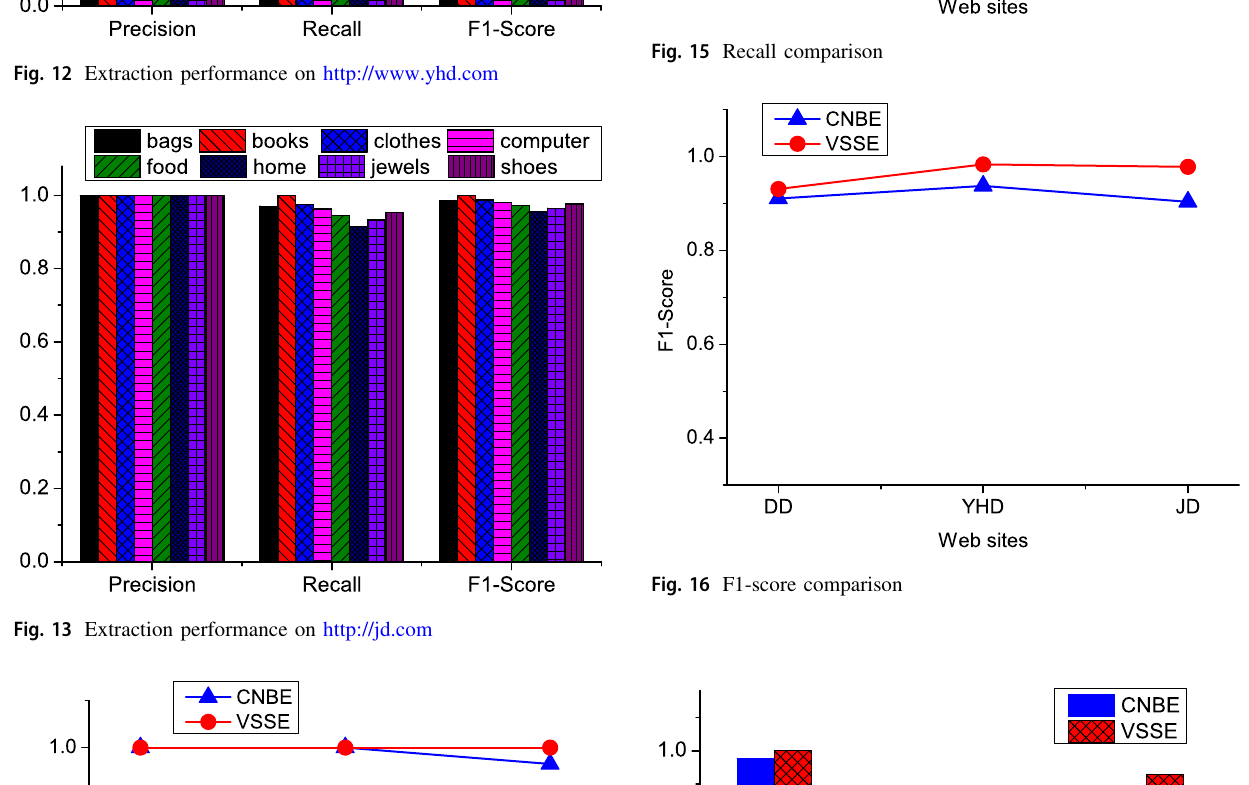
Fig. 15 Recall comparison